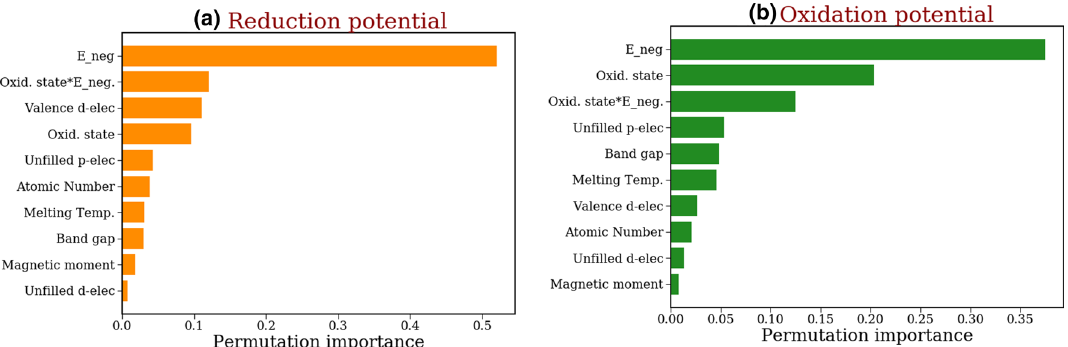
Figure 4. Permutation feature importance plots for the ( a ) reduction potential and ( b ) oxidation potential GB models. Features describing the same element property, measured through different statistics, are clustered together to avoid highly correlated